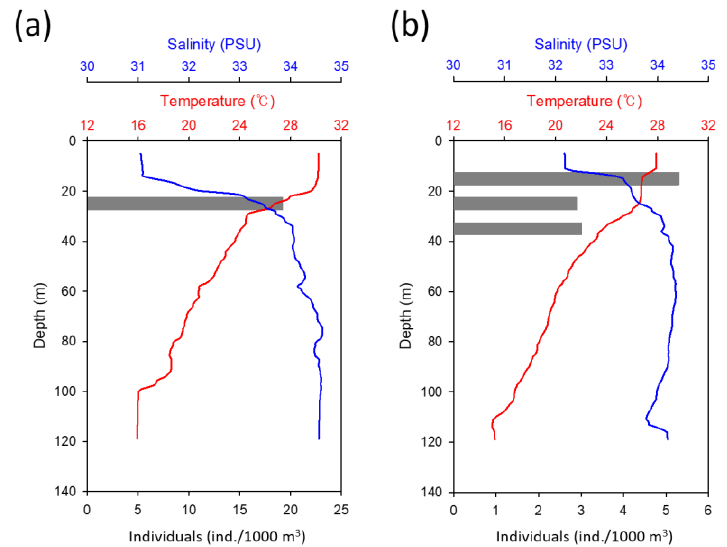
Figure 5. Water depth, salinity, and temperature distribution of M. cinereus eggs and preleptocephali collected in this study. ( a ) M. cinereus eggs, ( b ) M. cinereus preleptocephali and